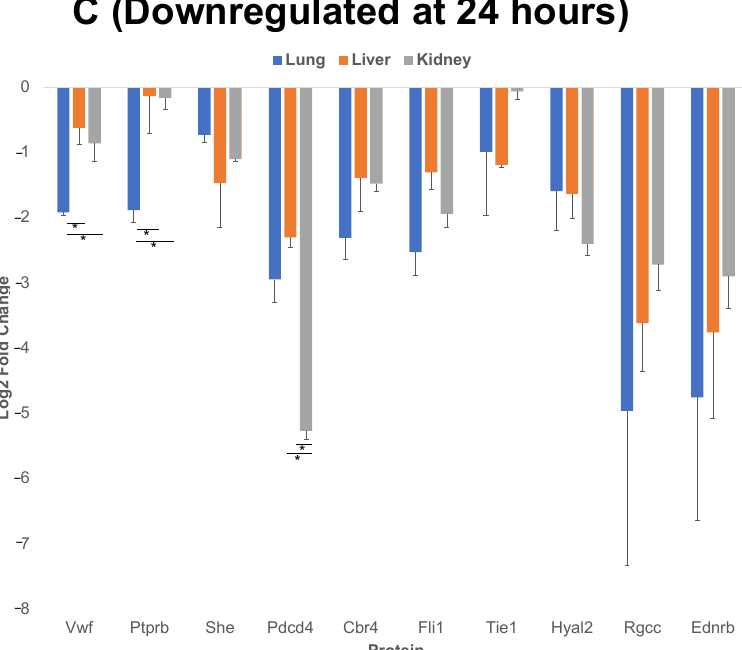
Figure 5. Comparison of 10 of the proteins that have the highest level of upregulation or downregulation compared to control post cytomix treatment at 4 h and 24 h. Panels A and B represent the 4 h and 24 h upregulated proteins, respectively, and panel C represents the downregulated proteins at 24 h. These bar plots highlight the differential expression of proteins across organs. The y -axis represents the log2 level change compared to the background levels of each protein. The blue, orange and gray bars represent lung, liver and kidney ECs, respectively. Data are plotted as mean ± SEM ( n = 3). Analysis of Variance (ANOVA) with Tukey post-hoc test was used to identify statistically significant differences. The “*” symbol indicates that there was a significant difference ( p < 0.05) between organs.